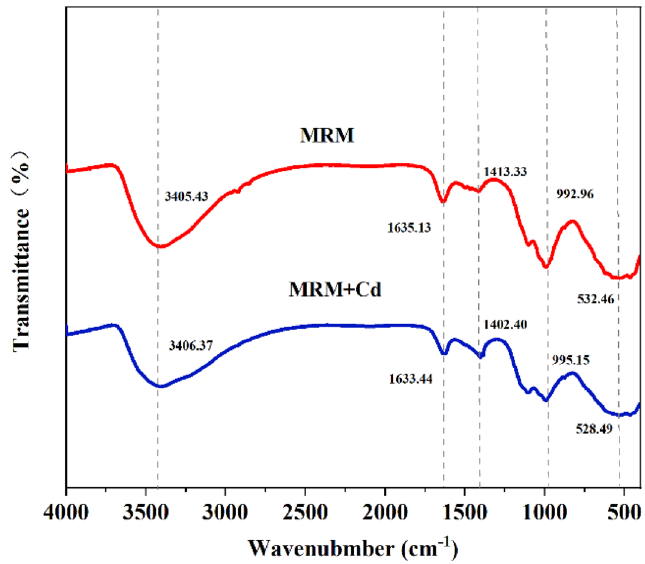
Figure 16. FTIR spectra of MRM before and after the adsorption of Cd 2+